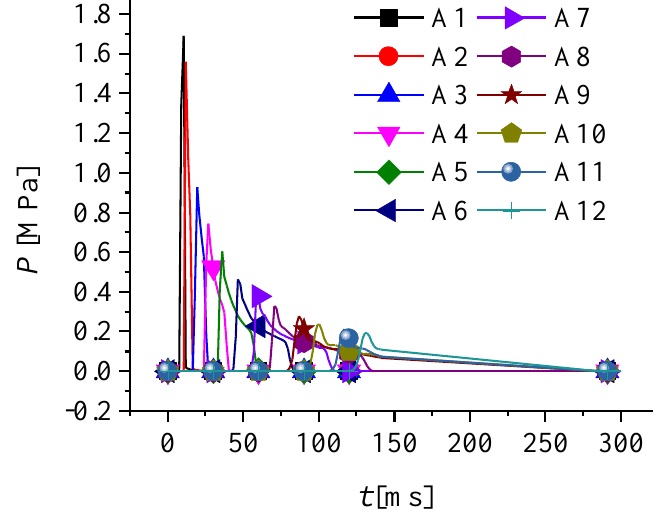
Figure 7. Pressure-time curves at 2 m gauges of shock wave in the air.